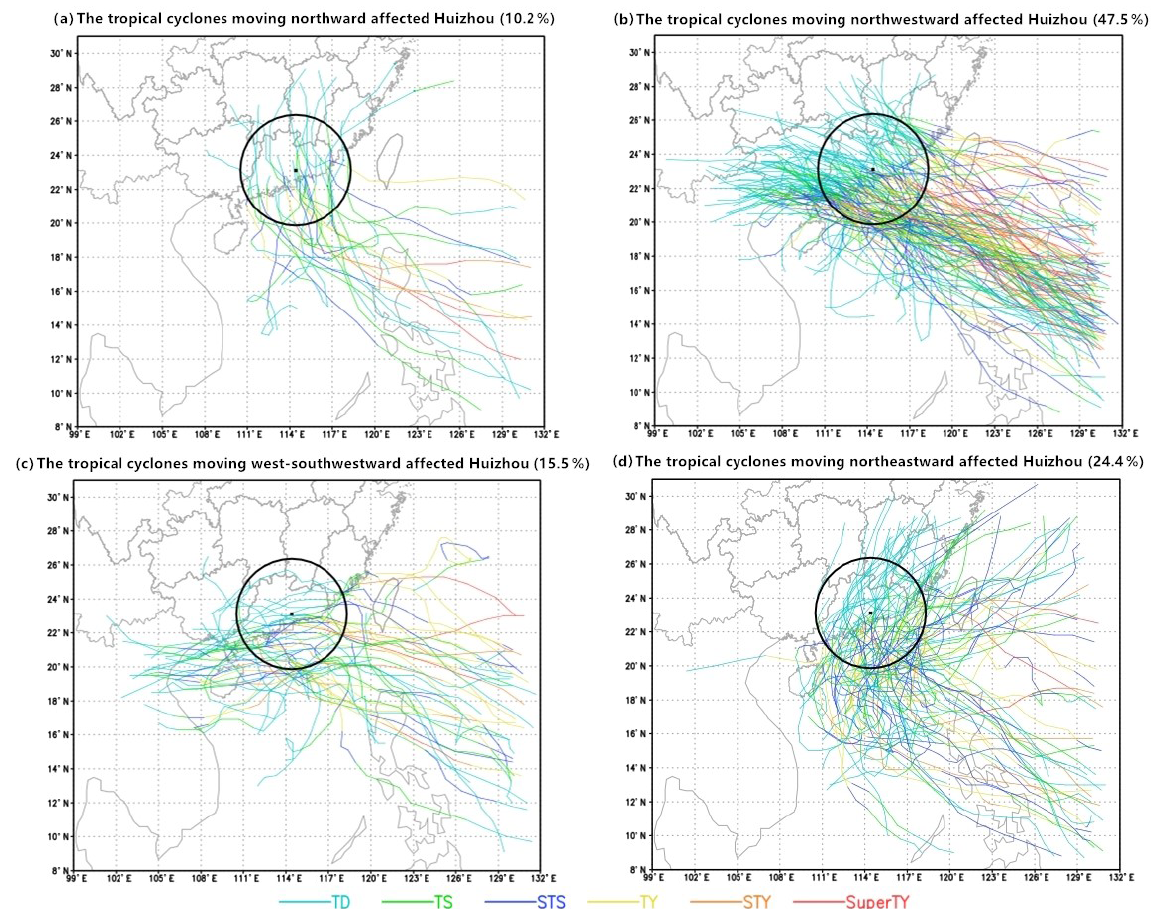
Figure 9. The tracks of tropical cyclones affected Huizhou from 1949 to 2017. There are six categories of tropical cyclones: tropical depression (TD), tropical storm (TS), severe tropical storm (STS), typhoon (TY), severe typhoon super (STY), and super typhoon (Super